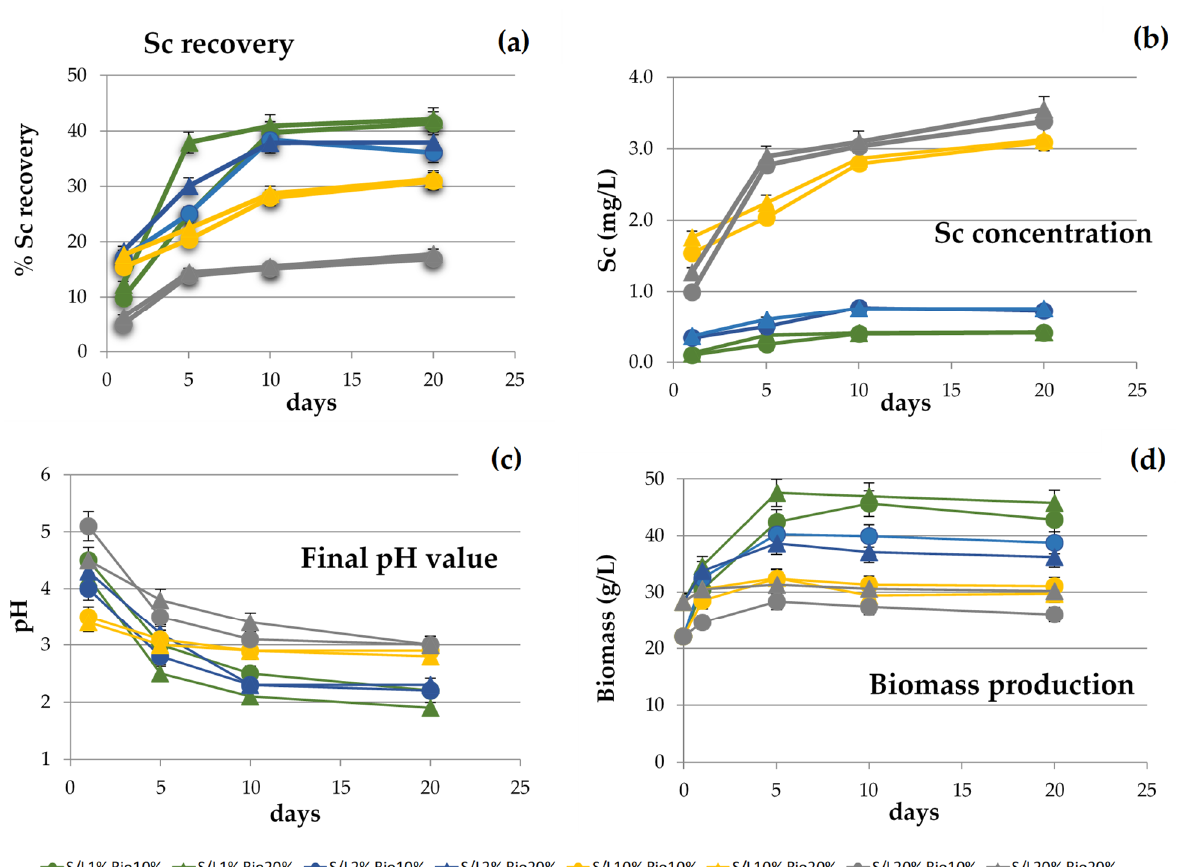
Figure 1. ( a ) Sc recovery, ( b ) Sc concentration, ( c ) pH of solution, and ( d ) biomass production by Acetobacter tropicalis in bioleaching experiments of 1, 2, 10, and 20% S/L- pulp density of BR with 10 and 20% w / w of bacterium suspension versus Table 2. The recovery of iron is consistently relatively low, rendering the bioleaching process quite selective, especially in the case of the 10% S/L solution and the 10% biomass dosage. This is in agreement with a previous bioleaching study that used Acetobacter sp. [22].